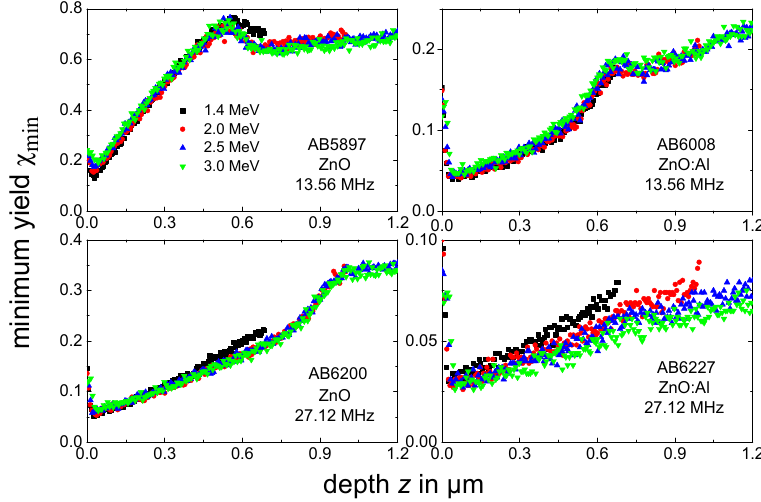
Figure 4. Minimum yield χ min versus depth z for each sample and all of the He ion energies applied. The names of the samples are given in the figure.